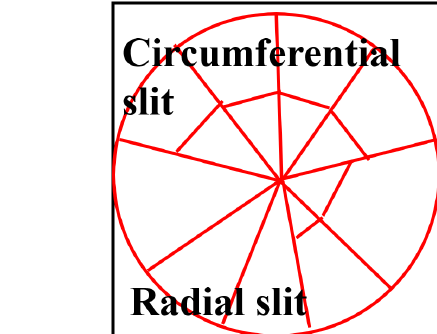
Figure 10. Radial and circumferential slits pattern when H = 0.59, T = 0.17.